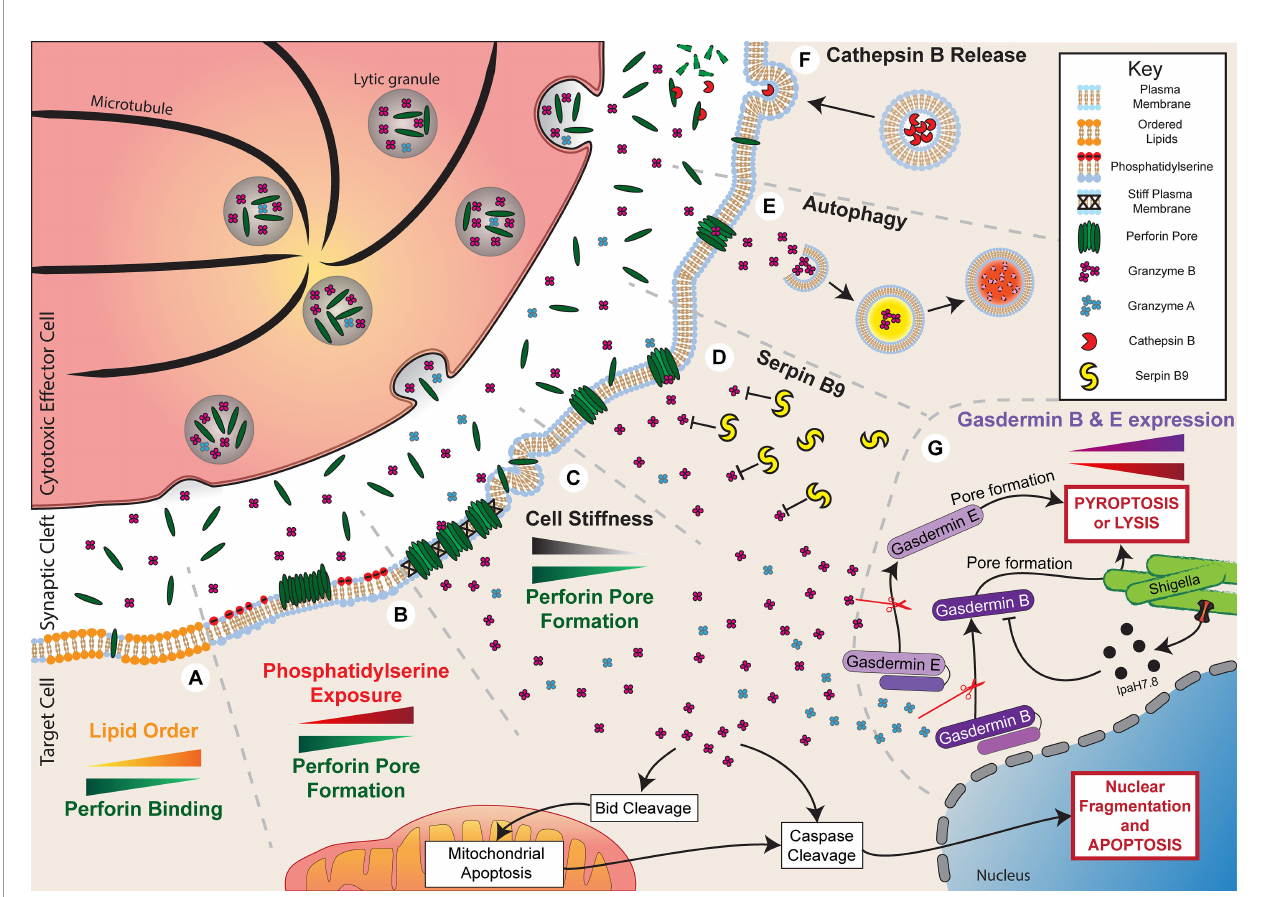
FIGURE 2 | Resistance to granule-mediated cytotoxicity. Activation of a cytotoxic effector cell at an immune synapse with a target cell leads to the polarisation and secretion of lytic granules containing perforin and granzyme B. Under normal circumstances, in the absence of any resistance mechanisms, the secreted perforin will form pores in the target cell membrane and allow entry of granzyme B. This process will initiate cell death through both direct cell lysis and the activation of apoptotic pathways. Target cells can employ multiple mechanisms to evade cytotoxicity. (A) Increased plasma membrane lipid order to reduce perforin binding. (B) Externalisation of phosphatidylserine to induce perforin aggregation rather than pore formation. (C) Reduced cell stiffness to prevent ef fi cient perforin pore formation. (D) Expression of Serpin B9 to directly inhibit Granzyme B activity. (E) Autophagy of Granzyme B to prevent activation of apoptotic pathways. (F) Secretion of Cathepsin B to degrade perforin. (G) Reduced gasdermin B and E expression or IpaH7.8-mediated ubiquitination and degradation of gasdermin B can reduce pyroptosis or lysis of shigella,